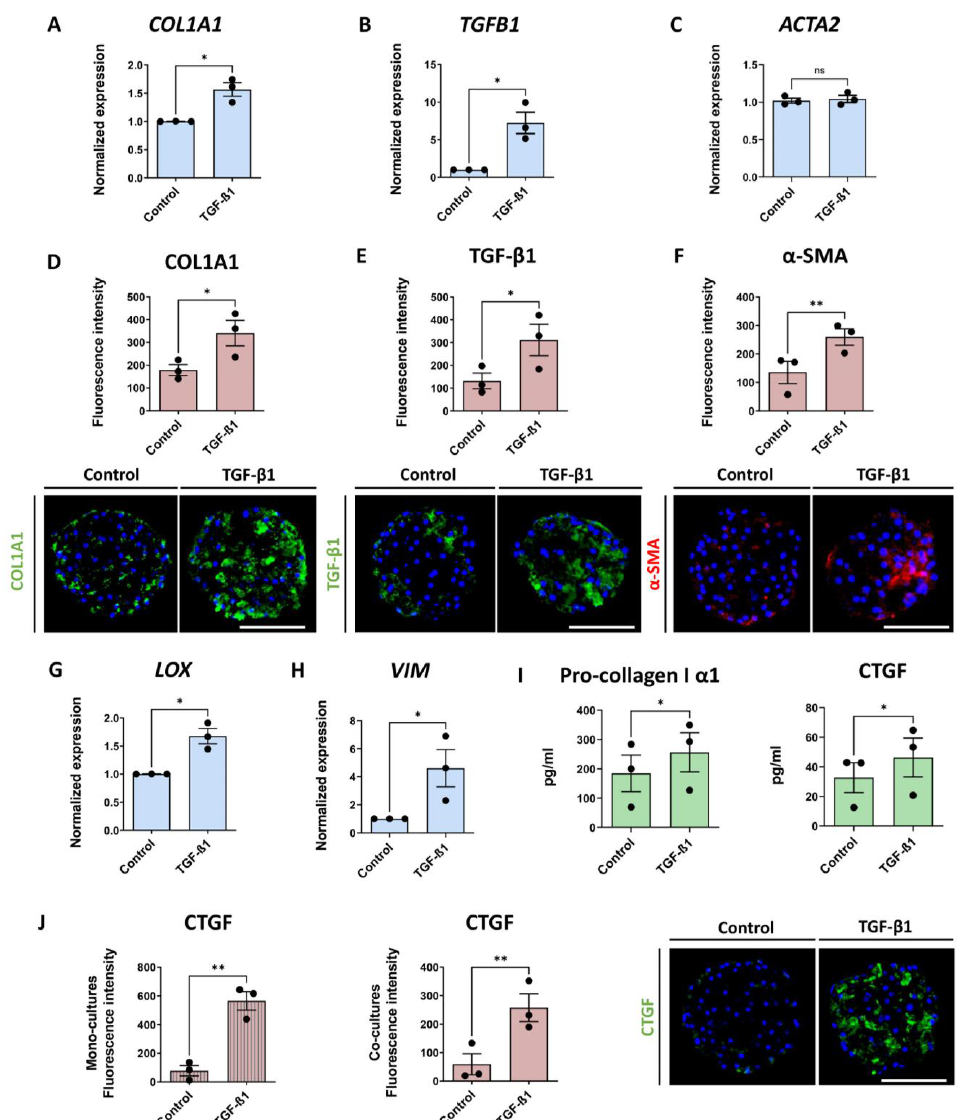
Figure 2. TGF- β 1 treatment of 3D human liver spheroids increases fibrotic markers as well as CTGF. Three-dimensional human liver spheroids were treated with 5 ng/mL of TGF- β 1 for 3 days. Blue bars represent mRNA expression data. Red bars show results of IHC analysis, where each dot represents an average result of at least 10 analyzed sections of spheroids in 1 separate experiment. Lastly, green bars represent results of ELISA analyses. ( A – C , G , H ) Transcription of COL1A1 , TGFB1 , LOX and VIM was increased 3 days after treatment initiation, while ACTA2 expression was unaffected (n = 3). ( D – F ) Representative images of key fibrosis related markers at day 10 including quantification of the increase of COL1A1, TGF- β 1 and α -SMA expression are shown (n = 3). ( I ) TGF- β 1 treatment increased the pro-collagen I α 1 and CTGF released into the culture medium. ( J ) CTGF was increased in both monoculture ( left ) and co-culture ( middle ) spheroids in response to TGF- β 1 treatment (n = 3), which is also visualized by immunofluorescence ( right ). In the Figure 2, all of the data presented, with the exception of ( J ) (( left ), monocultures), represents experiments performed in co-culture spheroids. Nuclei in the IHC images are shown in blue. The size of the spheroids is marked with a white scale bar of 100 µ m. Data are shown as mean ± SEM. Statistical analysis—Student’s t -test; * p < 0.05; ** p < 0.01; ns: not